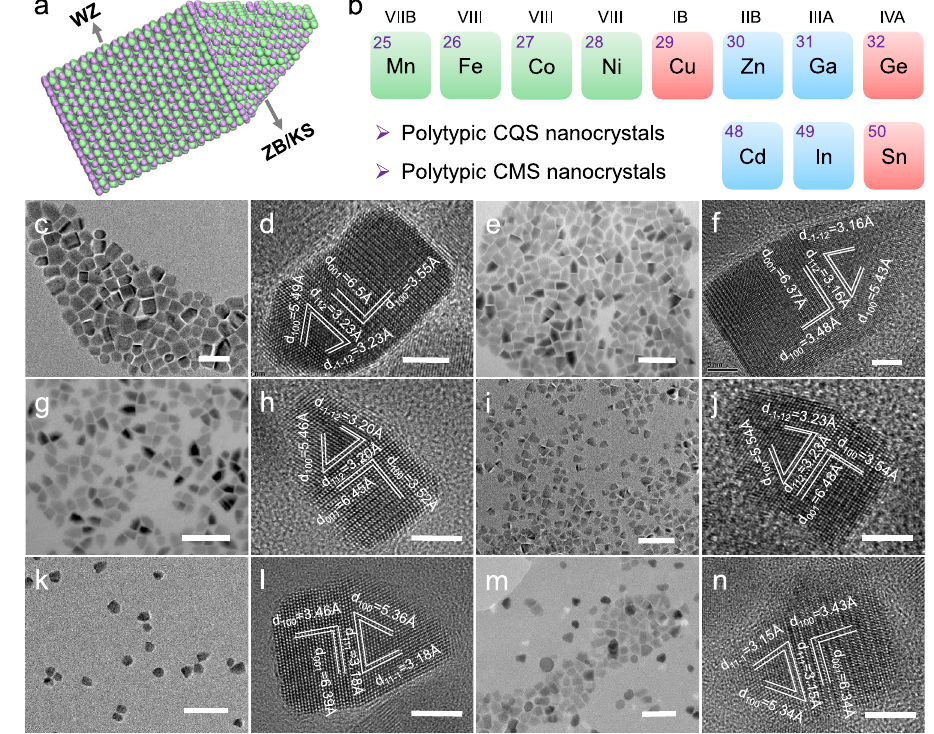
Fig. 4 | Characterization of the single-homojunction polytypic CQS nanocrystals. a Schematic graph of a single-homojunction polytypic nanocrystal. b Overviewofthe metalelementsinvolved inthe polytypicCQSnanocrystals.TEM ( c )andHRTEM( d )imagesofpolytypicCCdTSnanocrystals.TEM( e )andHRTEM( f ) images of polytypic CCoTS nanocrystals. TEM ( g ) and HRTEM ( h ) images of